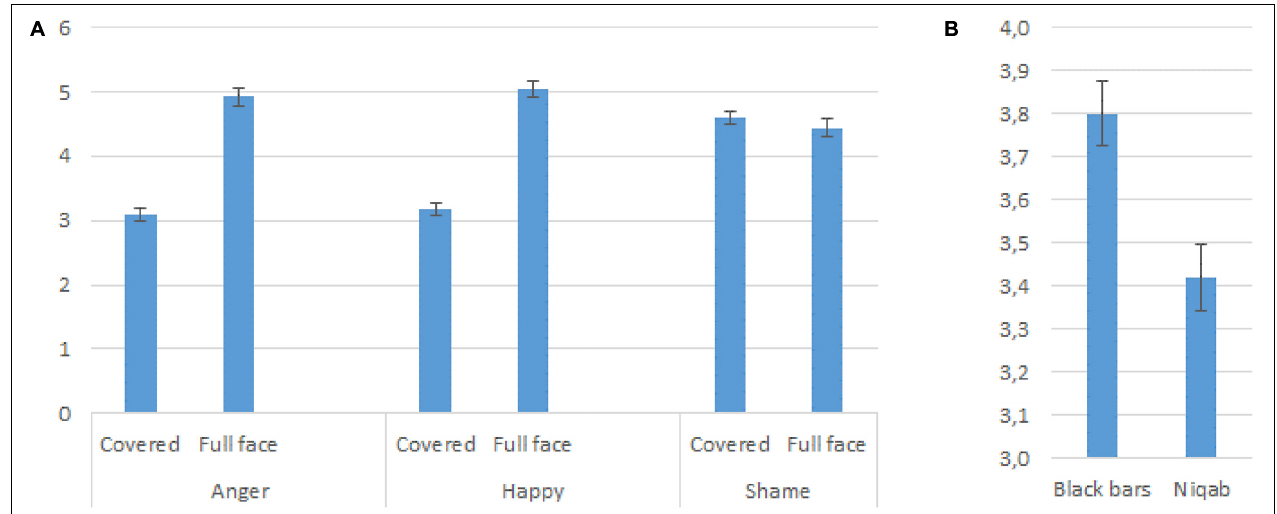
FIGURE 2 | Emotion congruent intensity ratings. (A) Predicted means showing an interaction between emotion display and face coverage; (B) Main effect of face coverage type showing that participants rated women wearing a niqab as expressing emotions less intensely compared to women whose faces were partly covered by black bars.